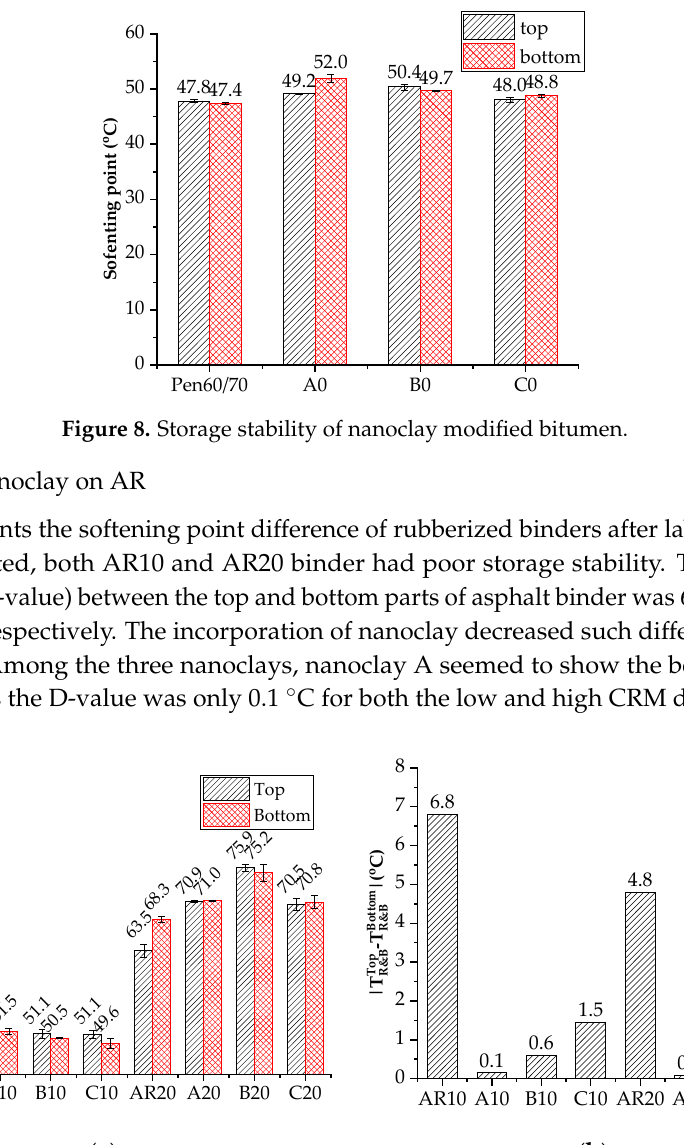
Figure 8. Storage stability of nanoclay modified bitumen.